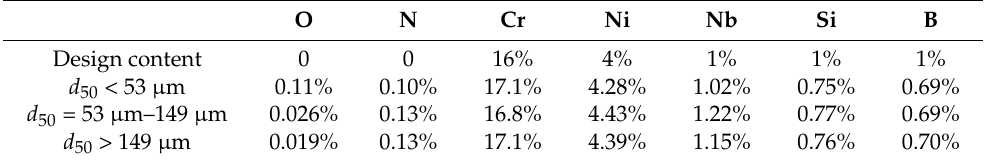
Table 1. Element content of